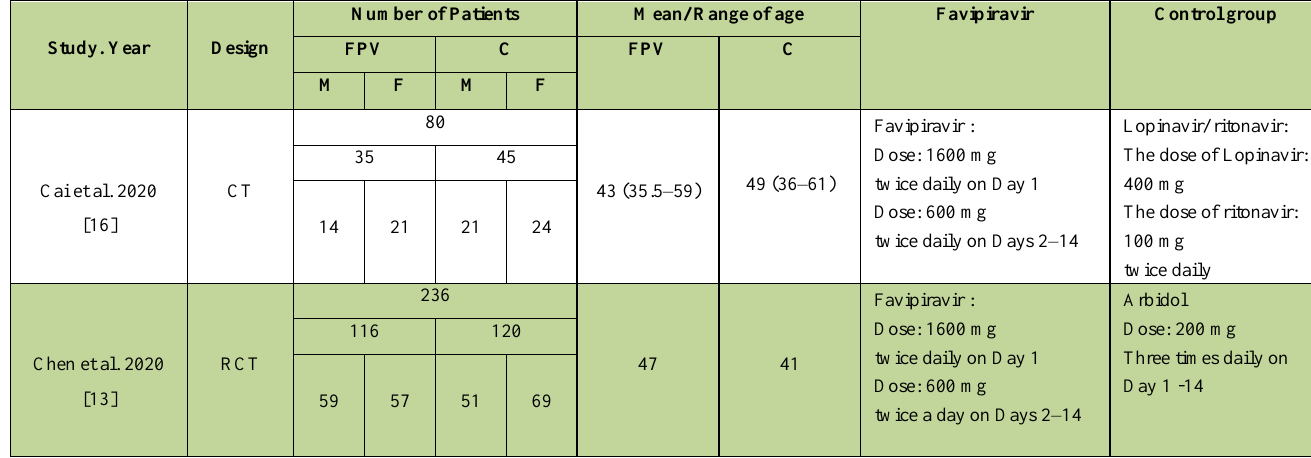
Table 2. Studies were selected for systematic review and meta-analysis.